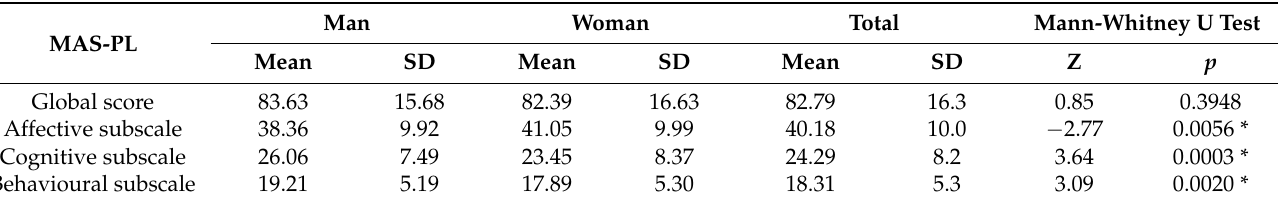
Table 6. MAS-PL scores relative to respondents’